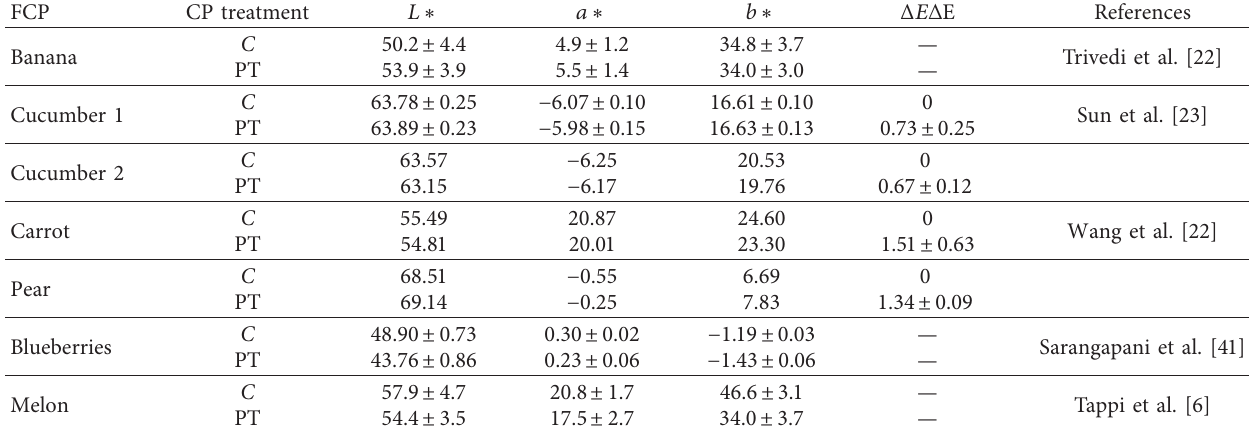
Table 2: The L ∗ ,a ∗ ,b ∗ , Δ E , and chroma values for various FCP after cold plasma treatment. FCP CP treatment L ∗ a ∗ b ∗ Δ E ∆ E Banana